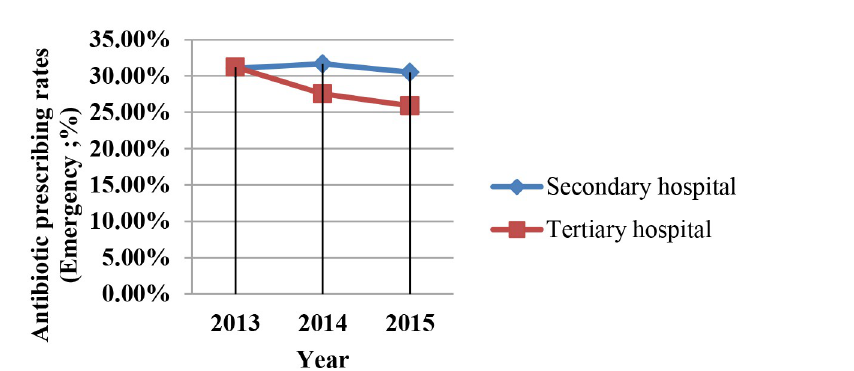
Fig 2. Antibiotic prescription rates of emergency patients in tertiary and secondary hospitals. Antibiotic prescription rates of emergency patients in Different Levels of Hospitals by